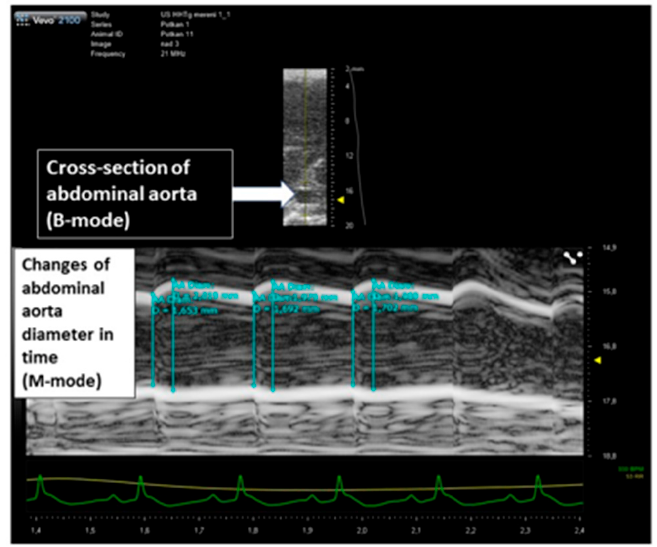
Figure 5. The principle of the assessment of abdominal aortic dilation in HHtg rats (ultrasound/M-mode measurements) for aortic strain calculation.